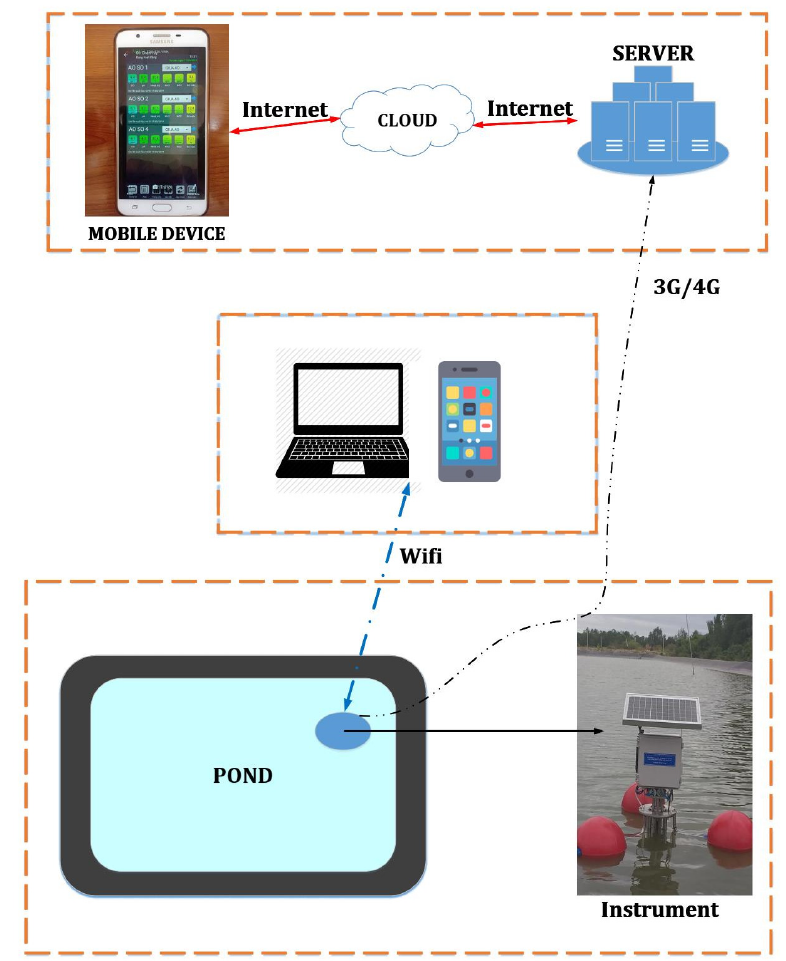
Figure 5. IoT application of our proposed